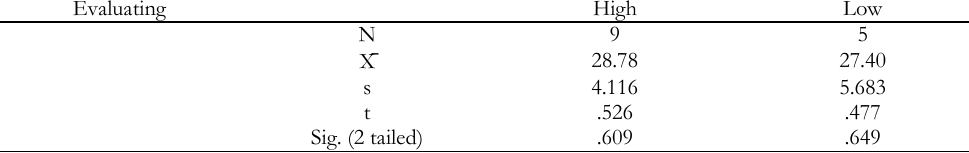
TABLE 3. Independent T-test for Evaluating Strategy on Metacognitive Writing Strategies Evaluating High Low N 9 5 X ̄ 28.78 .649 Significant value level at the 0.05 level (2-tailed)